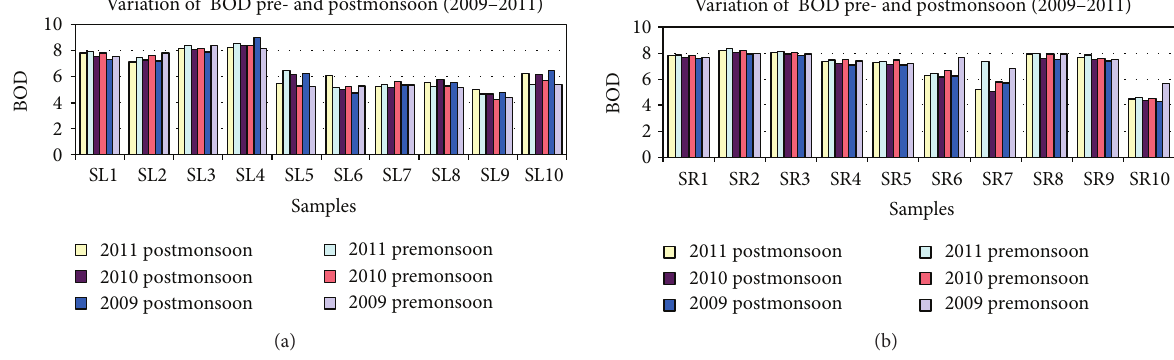
Figure 5: (a) Observations of BOD in water from the sites SL1–SL10 for the pre- and postmonsoon of 2009–2011. (b) Observations of BOD in water from the sites SR1–SR10 for the pre- and postmonsoon of 2009–2011.